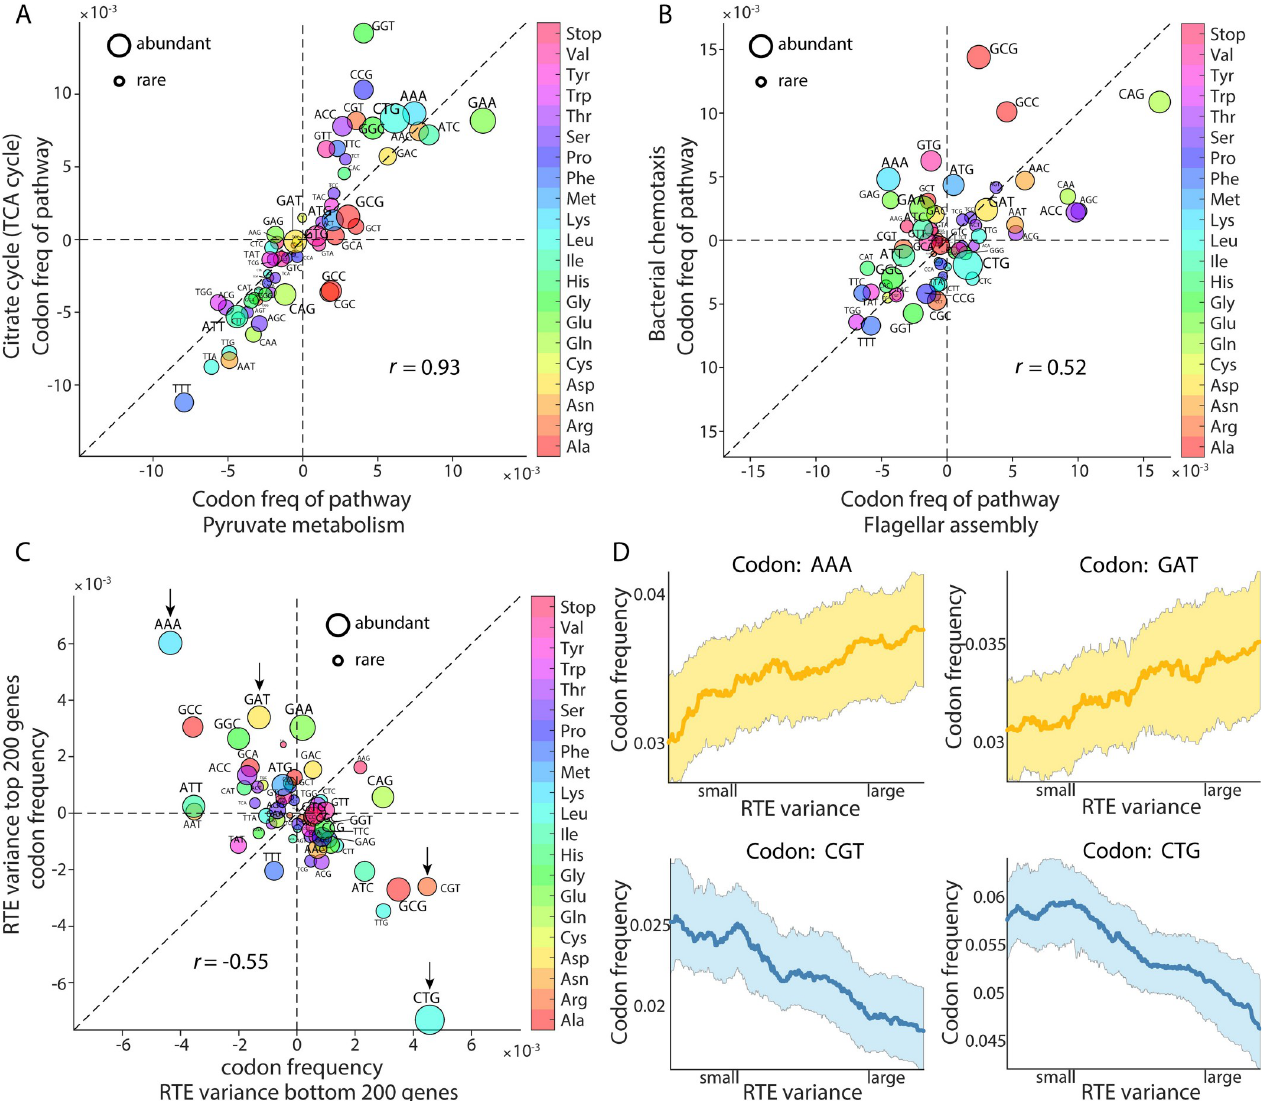
Fig 6. The relationship between codon usage and gene RTE patterns. (A) Correlation of codon frequencies between genes in the two pathways described in (Fig 5B). After removing the overlapped genes, there are 38 and 13 genes involved in each pathway, respectively. The 64 codons are dotted with sizes representing the rarity of codons in E . coli . (B) Correlation of codon frequencies between genes in the two pathways described in (Fig 5C). After removing the overlapped genes, there are 38 and 15 genes involved in them, respectively. (C) Negative correlation between the codon frequencies for the top 200 and bottom 200 genes in their RTE cross-condition variances. Four anti-correlated codons are indicated by arrows. (D) Relationship between the gene-by-gene RTE variance ( x -axis) and codon frequencies ( y -axis), for the four codons highlighted in (C). The average over 2914 genes is shown. The shadings represent the fluctuation of codon usage frequencies and the highlighted lines show smoothed mean